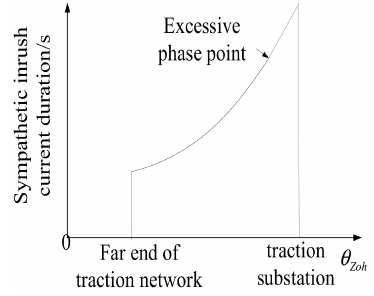
Figure 8. E ff ect of the line impedance angle on the duration of the sympathetic inrush.